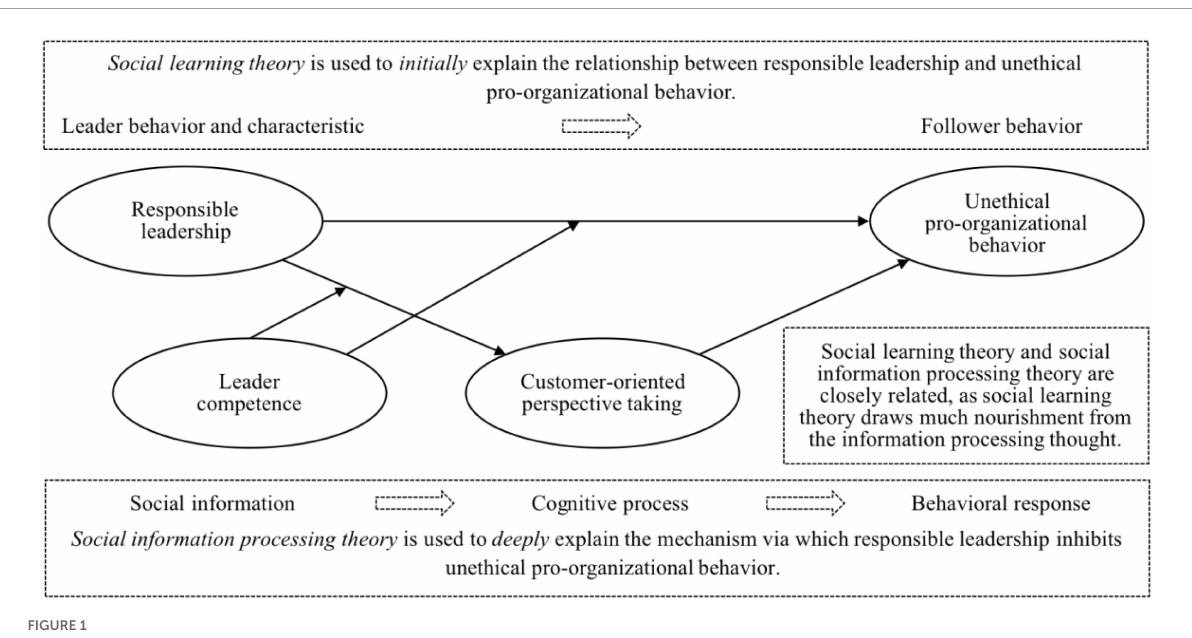
FIGURE1 The theoretical